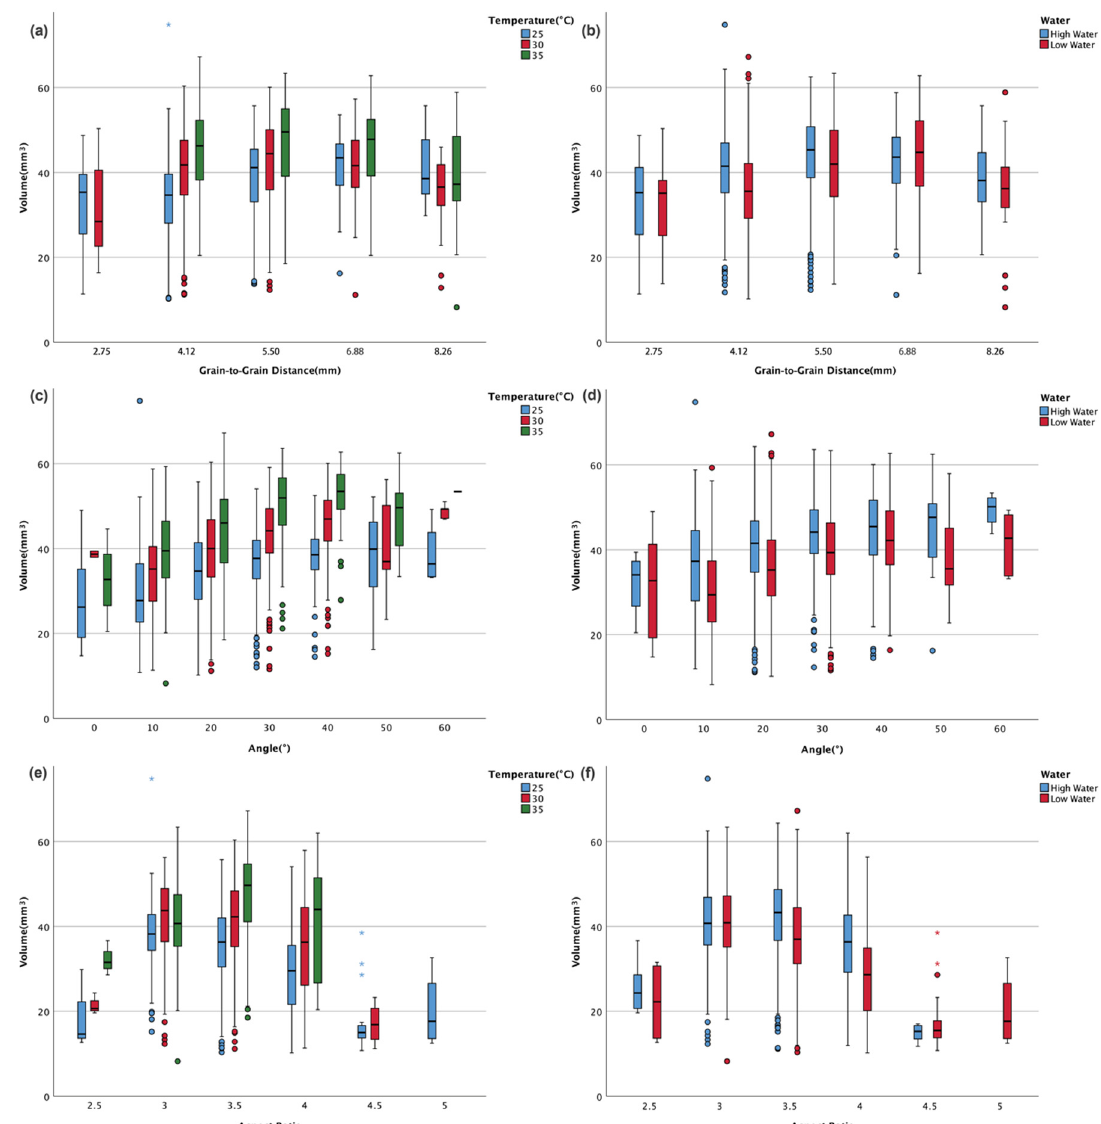
Figure 26. Correlation analysis of individual volume of grain between the key traits, including Grain-to-Grain distance, grain angle and grain aspect ratio. One sub-graph only considers one environment condition. ( a , c , e ) consider the effect of the Grain-to-Grain distance, angle and aspect ratio on volume at different temperatures. And ( b , d , f ) consider the effect of the Grain-to-Grain distance, angle and aspect ratio on volume under different water conditions.